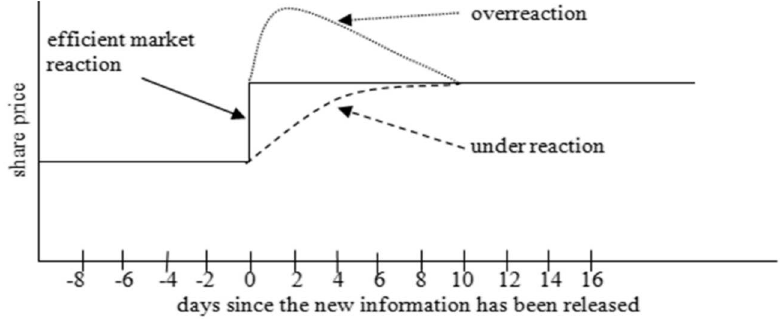
Figure 1. Price adjustment as a reaction to positive information on an efficient/not efficient market Source: (Jamróz, 2011, p.